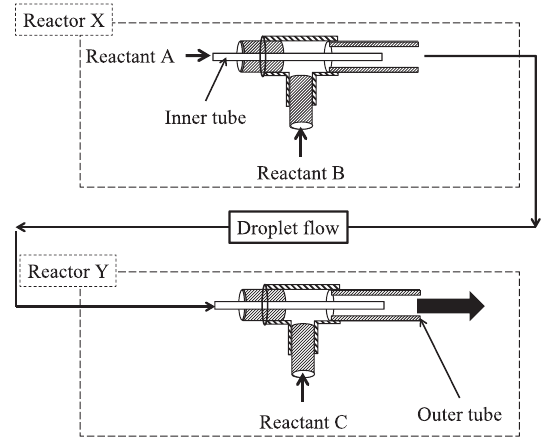
Fig. 5 Schematic view of the experimental apparatus using in the two- step